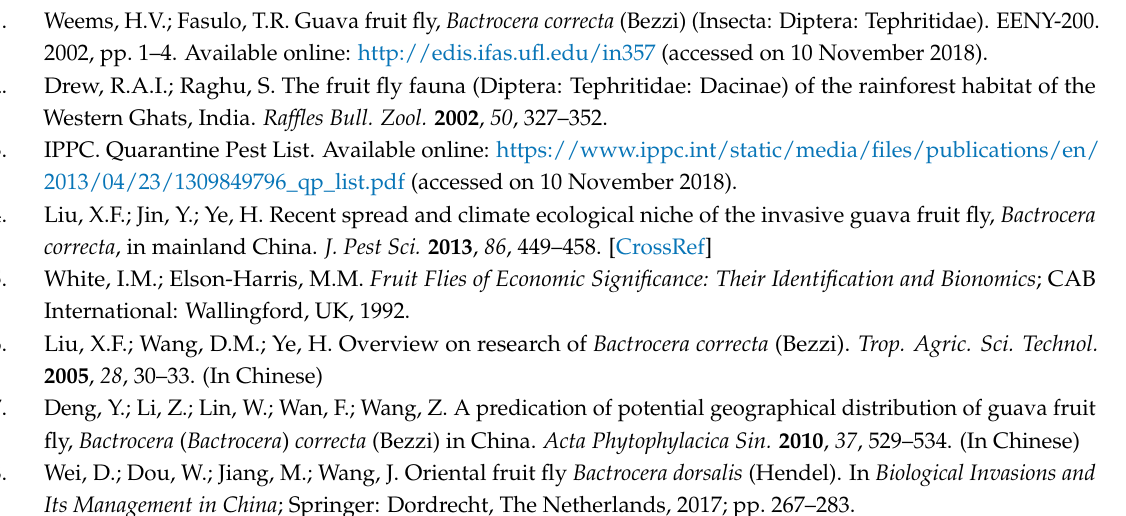
s1, Table S1: Chemical compounds identified by GC-MS in rectal glands of B. correcta females and males at different